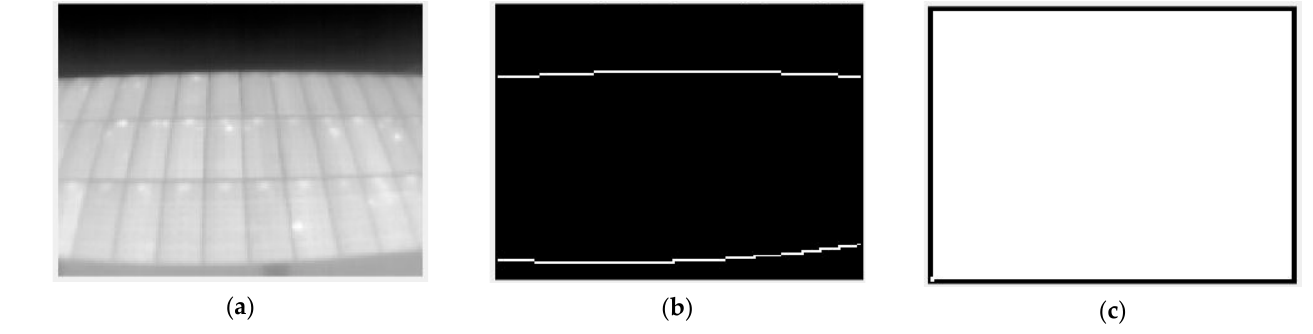
Figure 5. Result of removing small objects applied to the result of the “canny” filter. ( a ) Raw image; ( b ) Edge detection with Canny filter; and ( c ) Small objects removing.